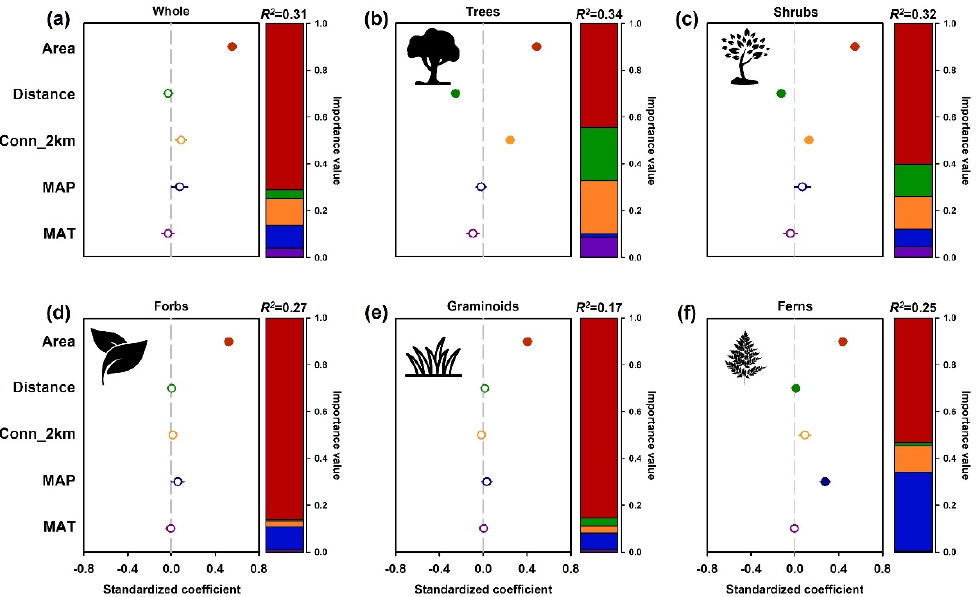
Figure 7. Standardized parameter estimates represent the effects size (circle) and standard error (bar) of five environmental factors for ( a ) whole, ( b ) trees, ( c ) shrubs, ( d ) forbs, ( e ) graminoids (sedges, grades, and rushes), and ( f ) ferns species richness on uninhabited islands, South Korea. The closed and open circles indicate significant and non-significant relationships between species richness and environmental factors, respectively. The relative importance of each factor was calculated as the ratio between the parameter estimate of the factor and the sum of all parameter estimates and then described as a percentage. In the left and right subgraphs of a graph, the same color represents the same variable. Abbreviations for the factors are shown in Figure 3.